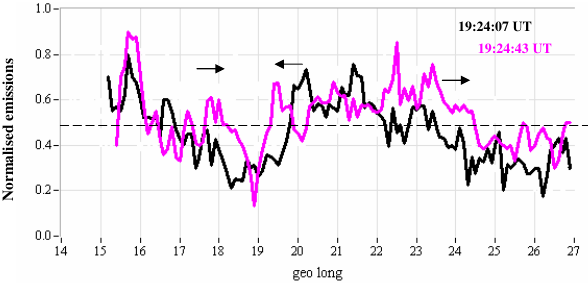
Fig. 10. Variation of red emissions along the arc shown for two consecutive images.